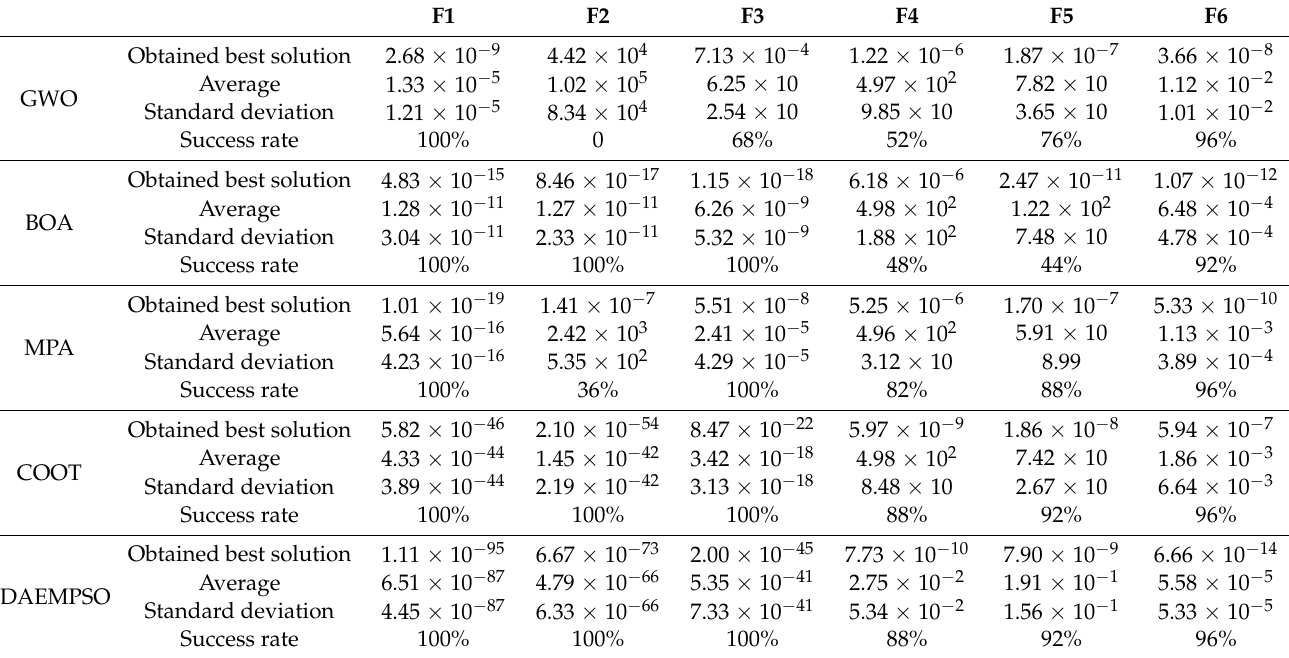
Table 3. Comparison of the optimization results of five algorithms for six functions (500 dimensions).